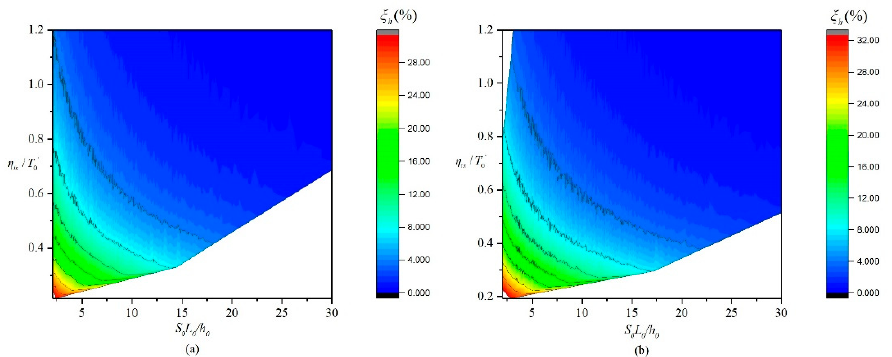
Figure 6. The distribution of relative error ξ h with consideration of channel length and width. ( a ) L 0 = [ 60, 45, 30 ] km, Q peak = 300 m 3 s − 1 , Q bottom / Q peak = 0.4, and B = 100 m. ( b ) Q peak = 300 m 3 s − 1 , Q bottom / Q peak = 0.4, B = [ 100, 80, 60 ] m, and L 0 = 60 km (in the selected values of other parameters were same as for the test shown in Figure 5 and all the possible tests according to the selected value of every parameters were calculated). The outermost line in each figure indicates that ξ h = 4% with a decrease inward of 4%.